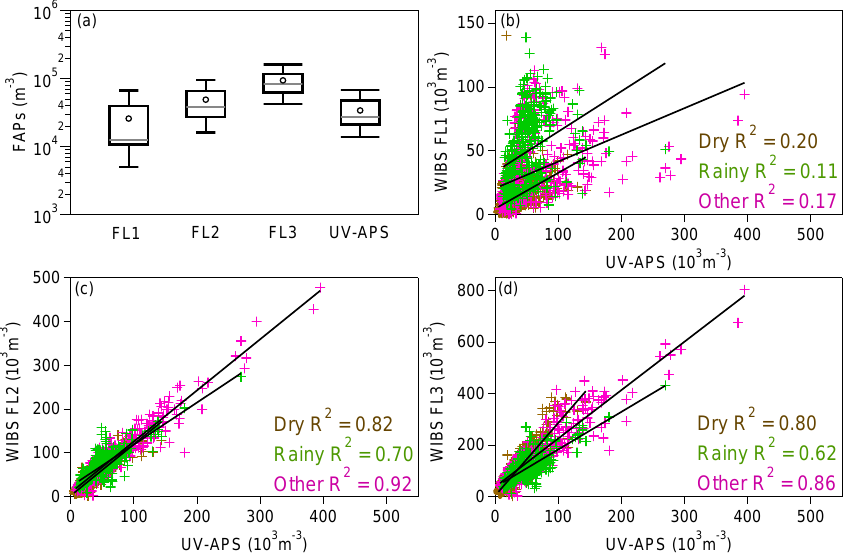
Figure 4. Number concentration of fluorescent particles as a function of instrument channel, averaged over entire measurement period. (a) Box-and-whisker plot of fluorescent particle number concentration for WIBS FL1, FL2, FL3, and UVAPS. Circle markers shows mean values, internal gray horizontal line shows median, top and bottom of box show inner quartile, and whiskers show 5th and 95th percentiles. (b) WIBS FL1 vs. UV-APS, (c) WIBS FL2 vs. UV-APS, and (d) WIBS FL3 vs. UV-APS. Crosses represent 5min average points. Linear fits assigned for data in each wetness